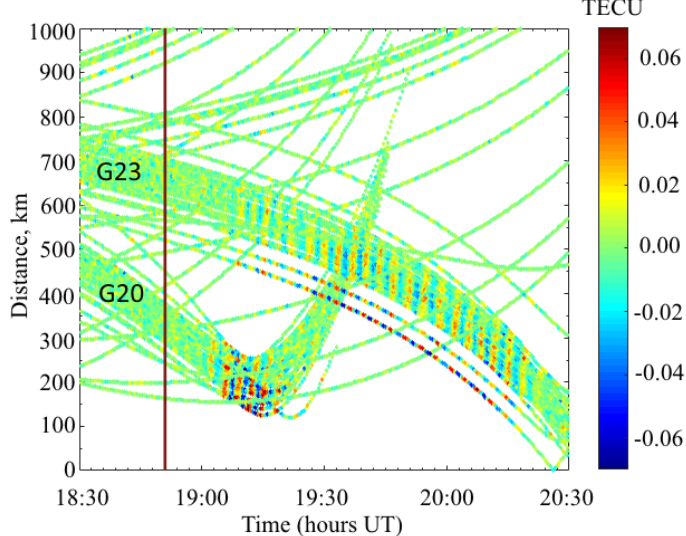
Figure 4. The traveltime diagram plotted by using satellites G20 and G23 within the time span 18:30 − 20:30 UT on 14 June 2009 shows the most prominent CVIDs. The vertical red solid line indicates the explosion time. Color represents the appropriate TEC amplitude.